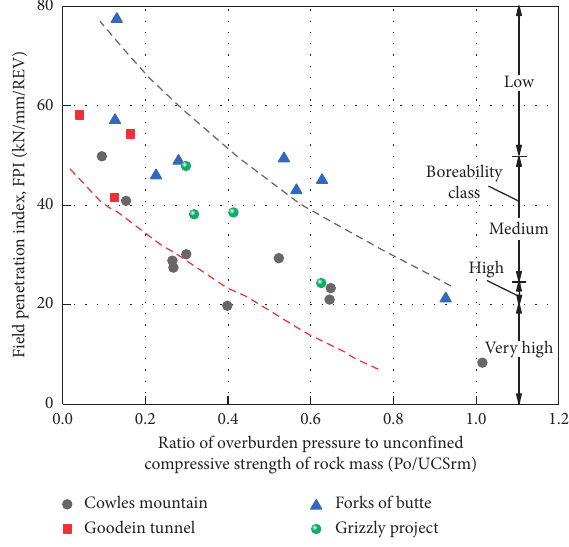
Figure 19: FPI correlation with the ratio of overburden pressure divided by UCS of rock mass